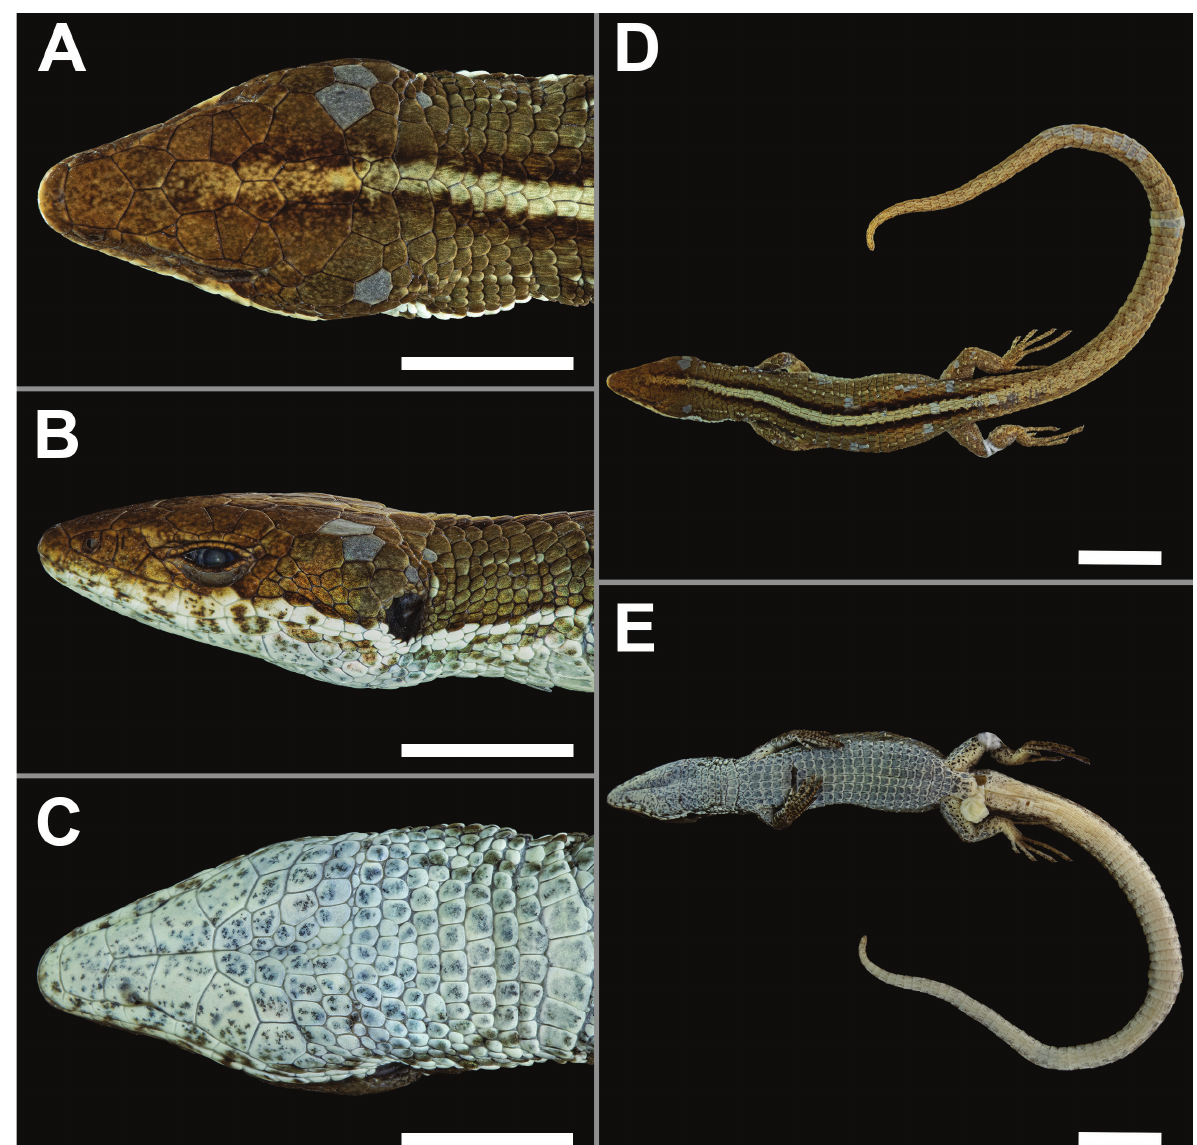
Figure 1. Dorsal ( A ), lateral ( B ) and ventral ( C ) views of the head, and dorsal ( D ) and ventral ( E ) views of the body of